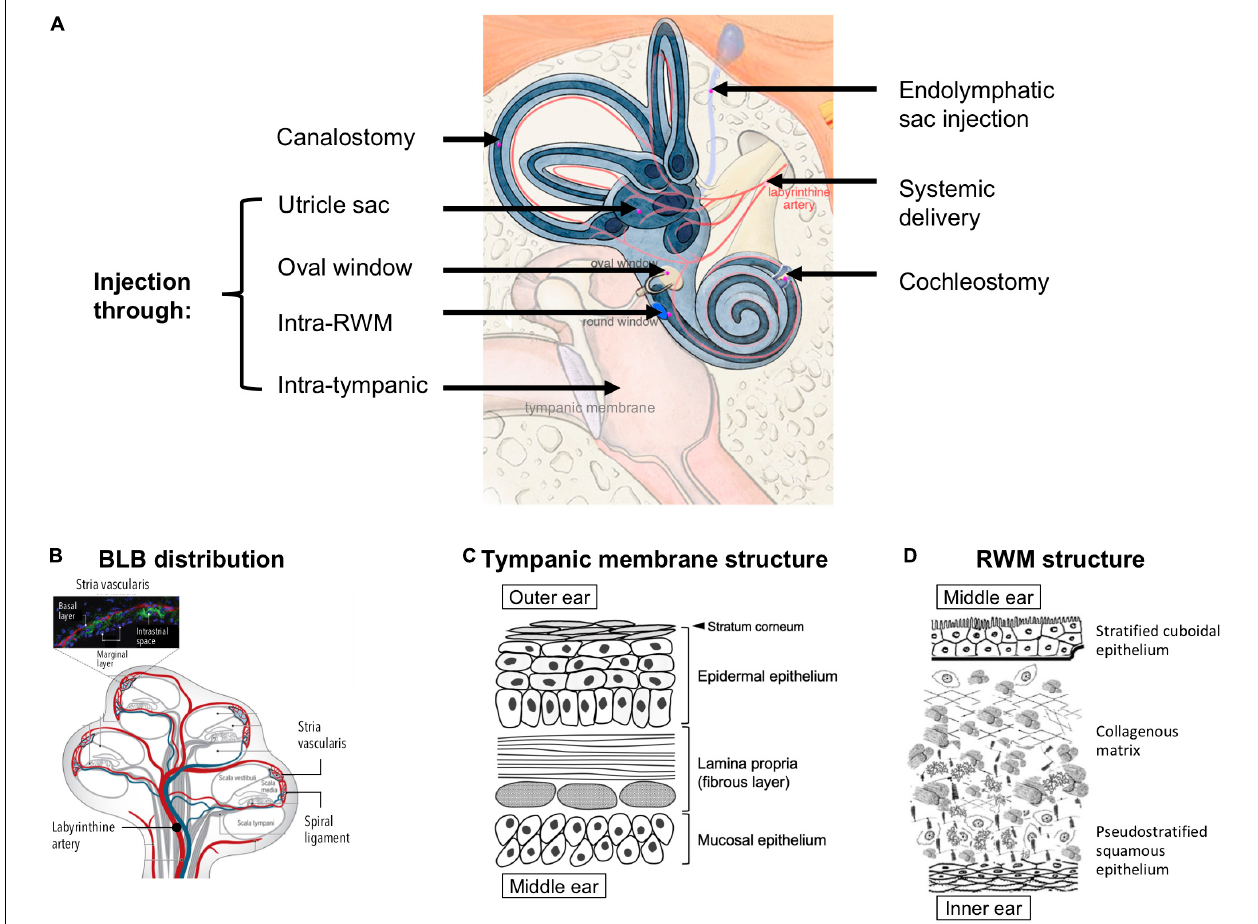
FIGURE 3 | (A) Possible anatomical routes for therapeutic delivery into the inner ear; adapted from Delmaghani and El-Amraoui (2020), available under Creative Commons license (CC BY 4.0). (B) Distribution of the blood labyrinthine barrier (BLB), proposed in the literature based on existing experimental evidence; reprinted from Nyberg et al. (2019) with permission. (C) A schema of the structures and cell types in the tympanic membrane. (D) Structure of the round window membrane (RWM); adapted from Pyykkö et al. (2013), available under Creative Commons license (CC BY-NC 4.0).